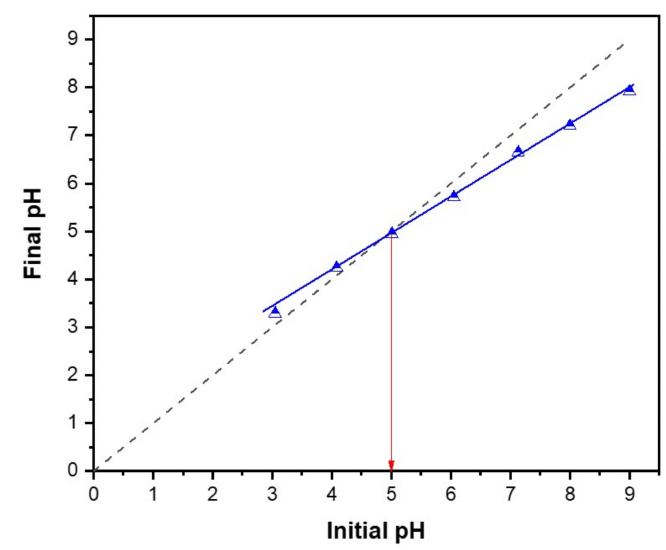
Figure 7. Determination of the pH pzc of the RPNS sample.